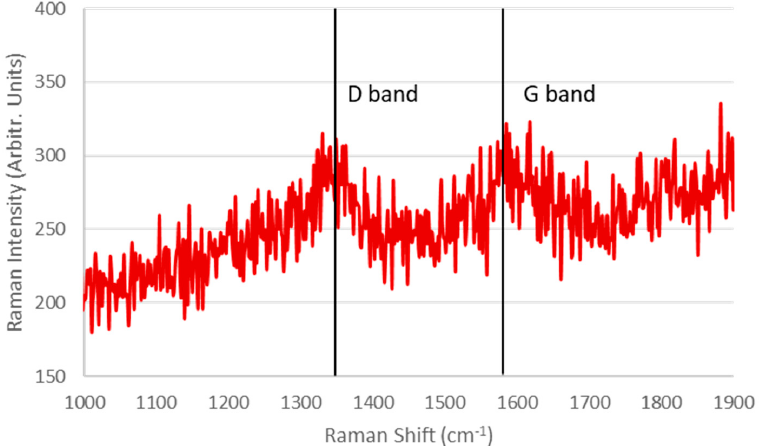
Figure 12. Raman analysis carried out on the used Rh0.6-CL-R-CZOm catalyst. The two bars indicate the presence of carbon.